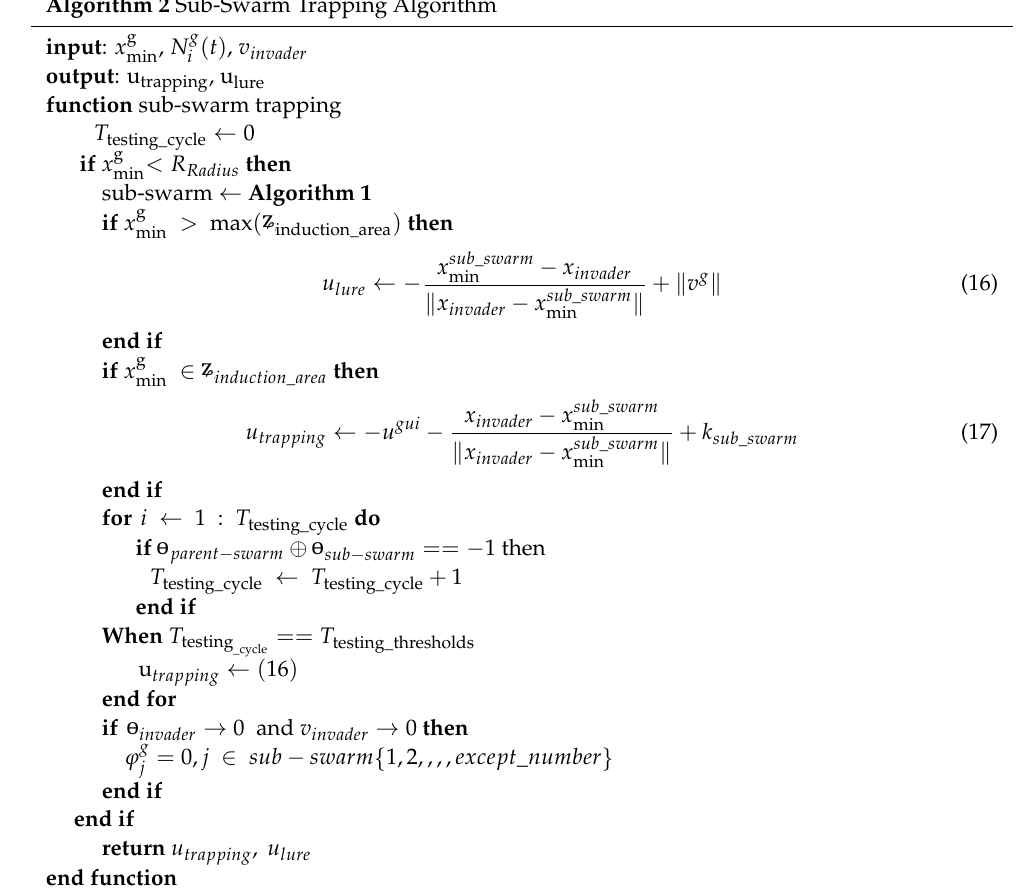
Algorithm 2 Sub-Swarm Trapping Algorithm